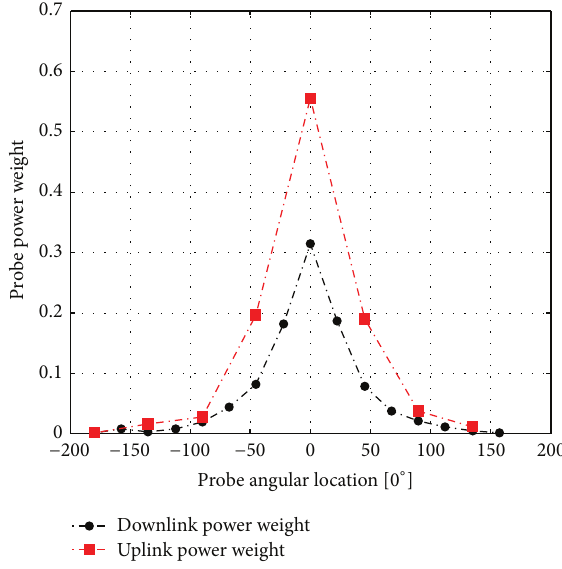
Figure 7: Power weights for the downlink (with 𝑁 𝑑 = 16 ) and uplink (with 𝑁 𝑢 = 8 ) channel model. The target PAS for the uplink and downlink is a single Laplacian shaped spatial cluster with AoA = 0 ∘ and AS = 35 ∘